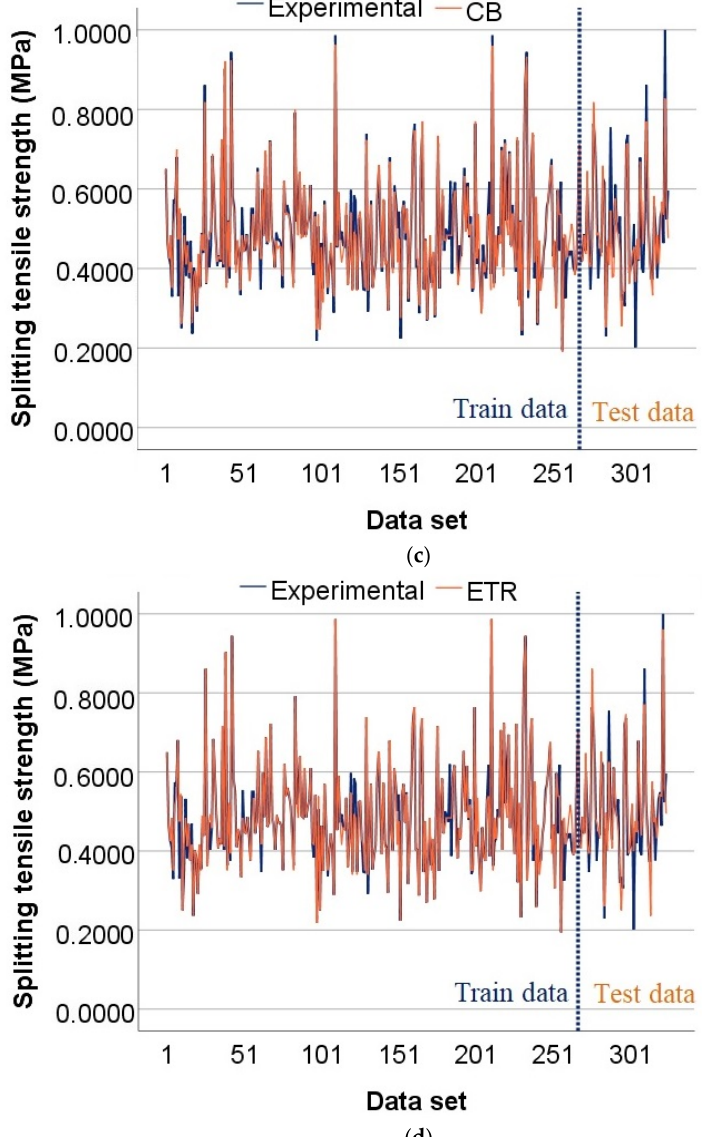
Figure 9. Actual prediction distribution of splitting tensile strength for models: ( a ) XGB; ( b ) GB; ( c ) CB; and ( d ) ETR.